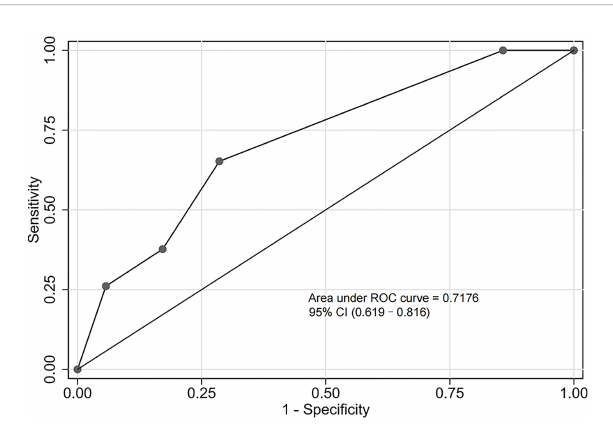
FIGURE 6 Receiver operating characteristic (ROC) curve of the predictive model for the validation cohort. The area under the ROC curve was 0.718 (95% con fi dence interval: 0.619 – 0.816), indicating a good prediction performance of the model in the validation cohort.